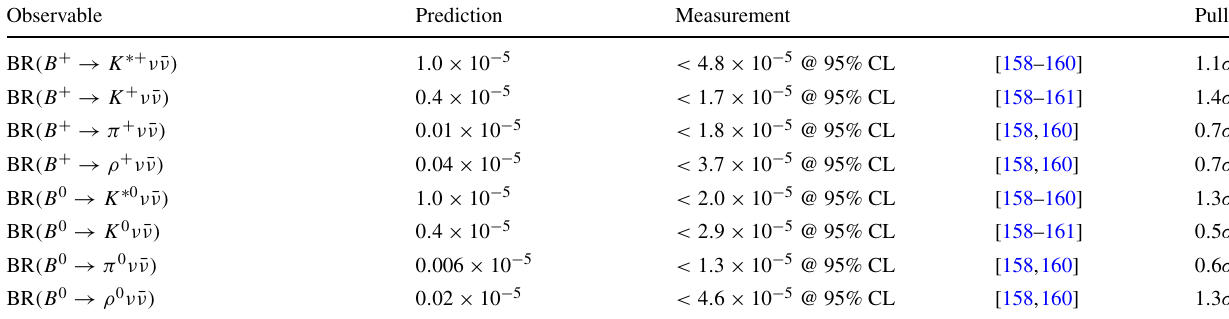
Table 8 b → q νν observables